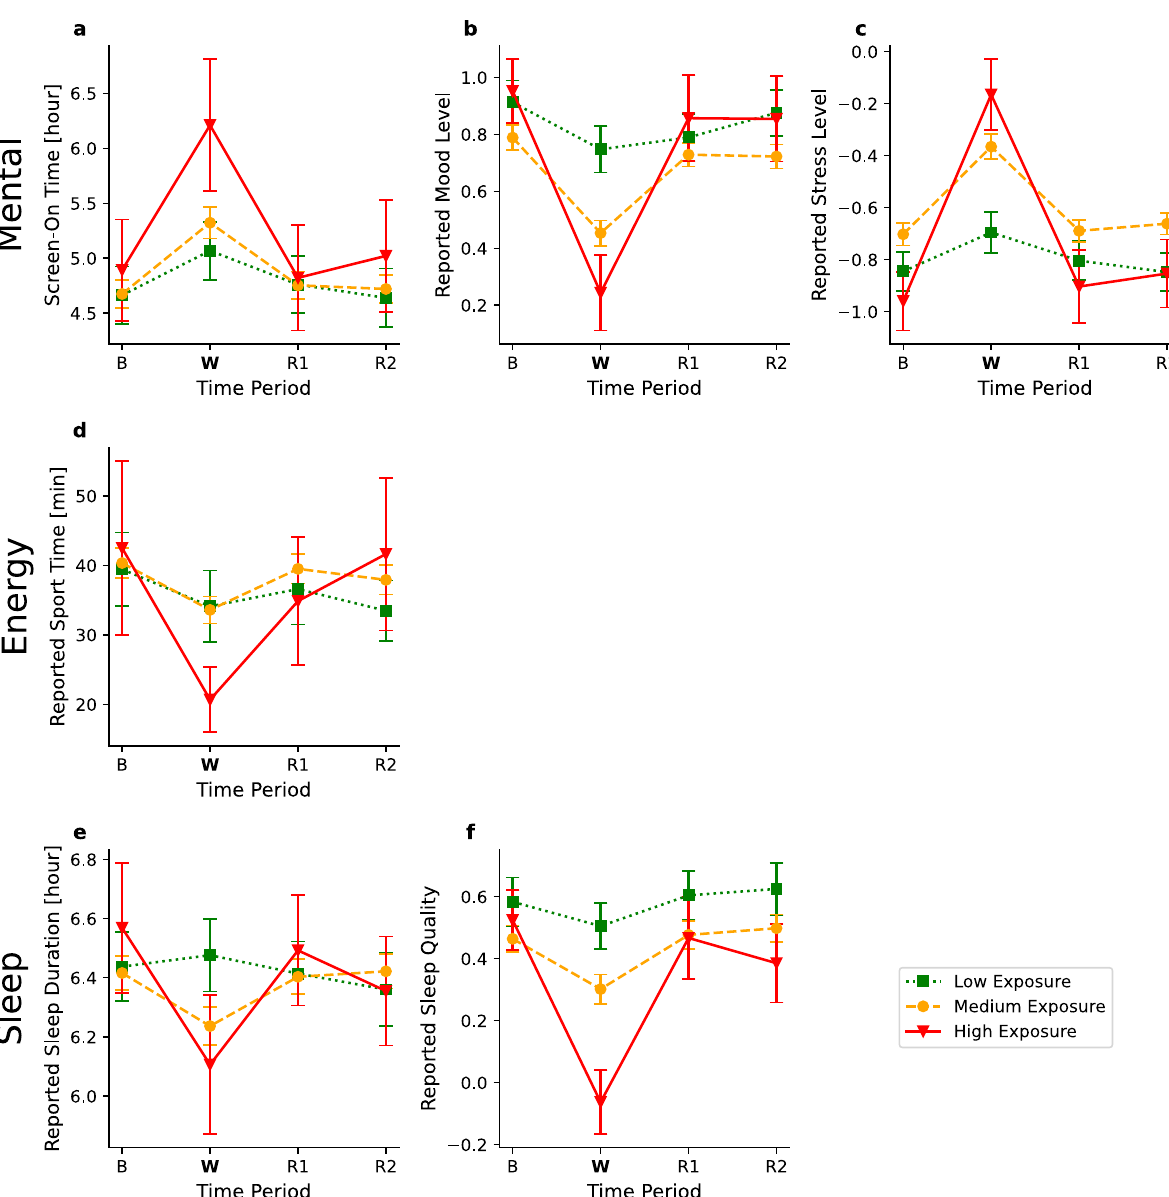
Fig. 3 Effects of the war by exposure group for various well-being indicators. The presented well-being indicators include a Screen-on time in hours b Reported mood level, c Reported stress level, d Reported sport time in minutes, e Reported sleep duration in hours, and f Reported sleep quality. The x-axis represents four time periods: baseline period (B), war period (W), fi rst “ back to routine ” period (R1), and second “ back to routine ” period (R2). The y-axis represents the mean value for the examined well-being indicator. Error bars represent a single standard error. The three plots represent the exposure groups: high exposure (solid red), medium exposure (dashed orange), and low exposure (dotted